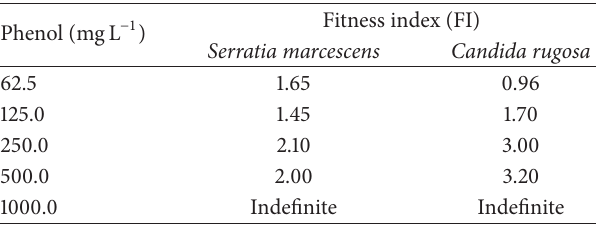
Table 1: Fitness index of Serratia marcescens and Candida rugosa under the effect of different phenol